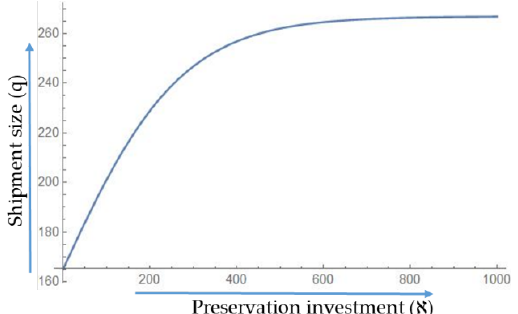
Figure 6. Impact of preservation investment on optimal shipment size.